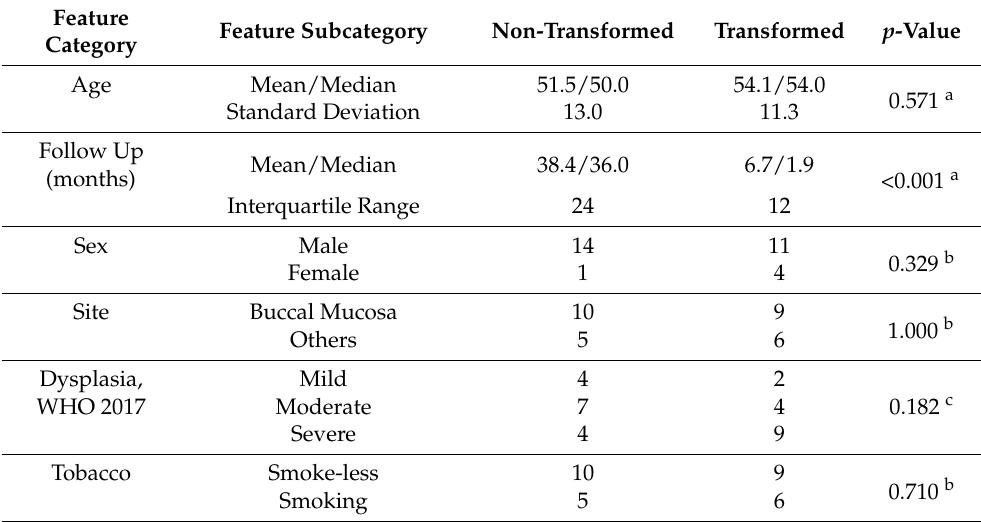
Table 1. Clinicopathological features of dysplasia cases with 5-year clinical